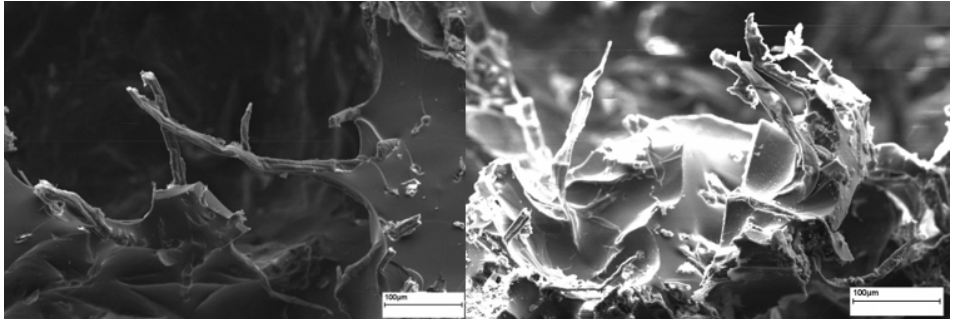
Figure 2. The SEM images of cellulose fibres in AESO 4 foams.